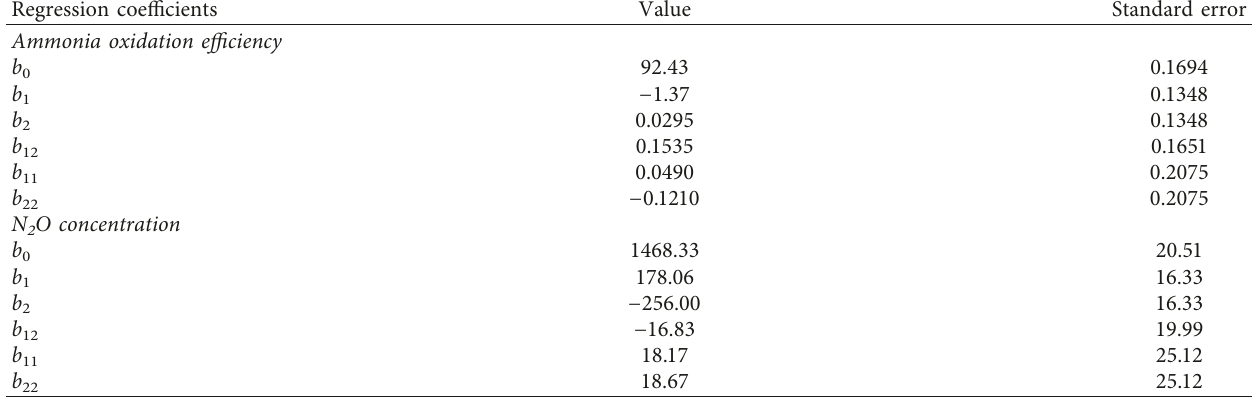
Table 6: Regression coefficients of the second-order polynomials models for ammonia oxidation efficiency ( R ( R 2 ).